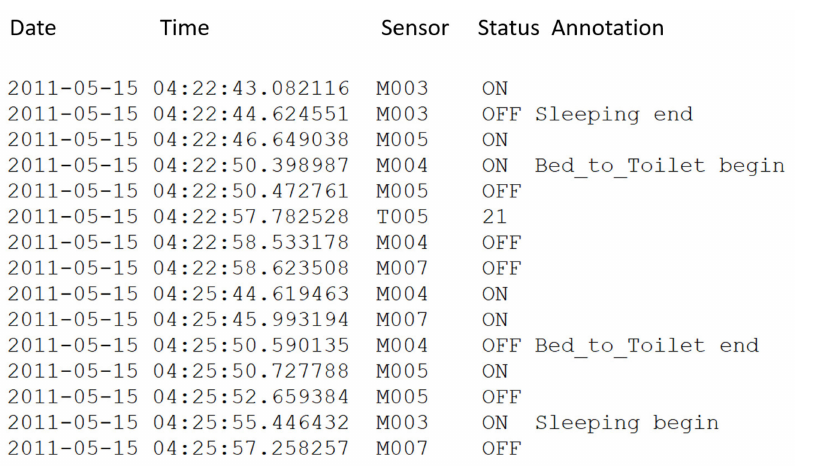
Figure 6. Format of Aruba dataset.